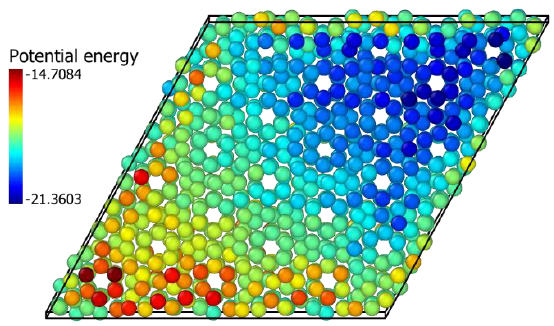
Figure 7. ZrO 2 (111) over In 2 O 3 (111) physical mixture. In 2 O 3 oxygen atoms potential energy at the interface (eV).